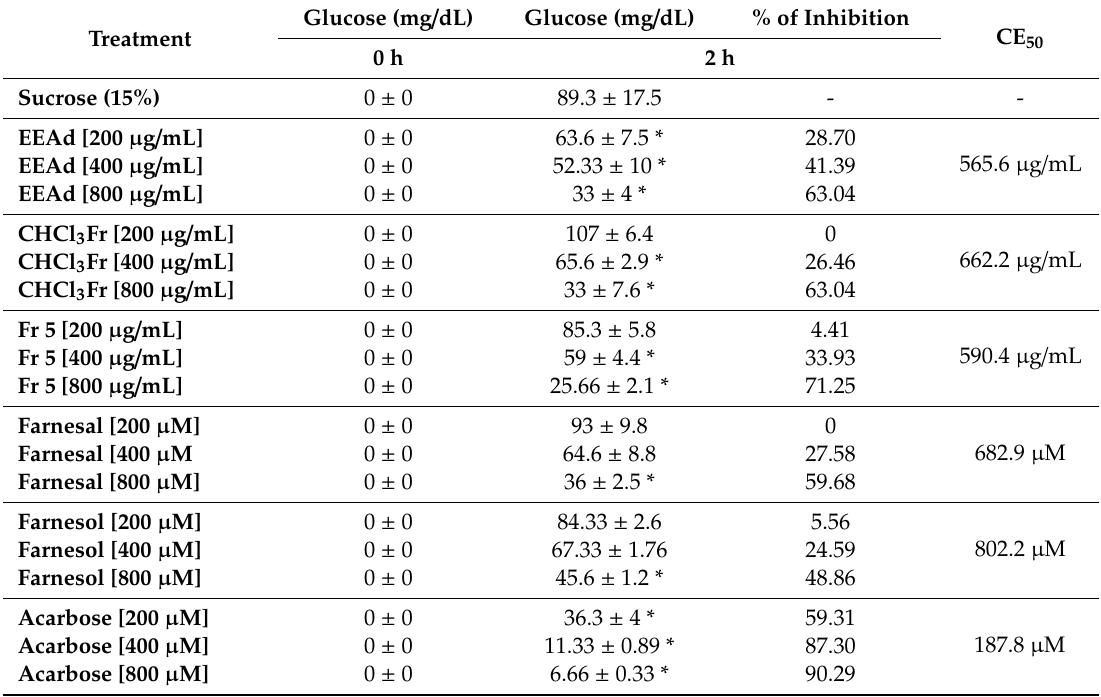
Table 2. Quantity of glucose measured in the external aqueous medium, percent of inhibition and CE 50 calculated after addition of treatments on intestinal sucrose hydrolysis (ISH) inhibition test. Glucose (mg / Treatment